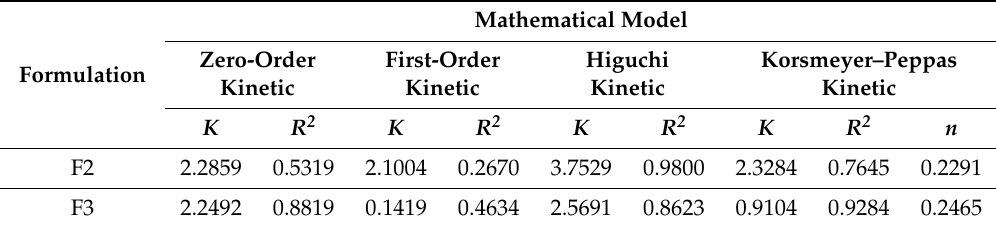
Table 3. Mathematical characteristics of the chitosan tablets with Chelidonii herba lyophilized extract (F2–F3).